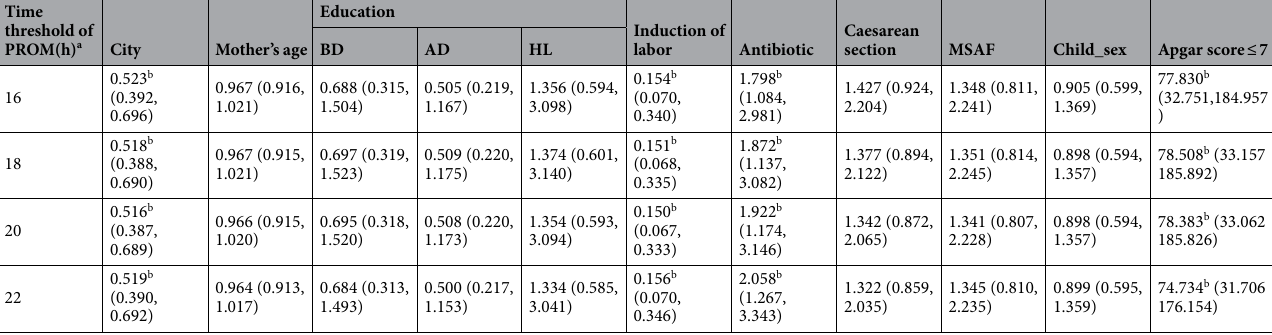
Table 5. Adjusted OR of other factors at time thresholds with significant differences of EOP in 3 days according to length of time of PROM. a Length of time of ruptured membranes from 0 h through specific time threshold. b P < 0.05.